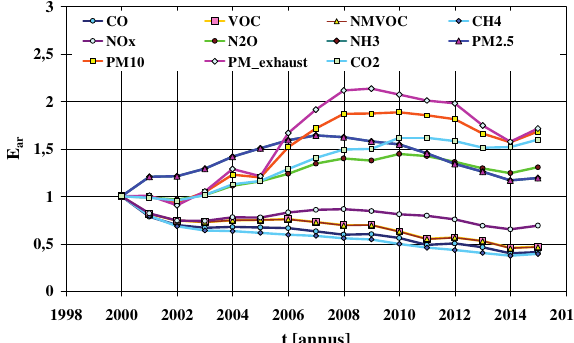
Fig. 12. National annual emission of particulate matter PM2.5 from tribological elements of passenger cars